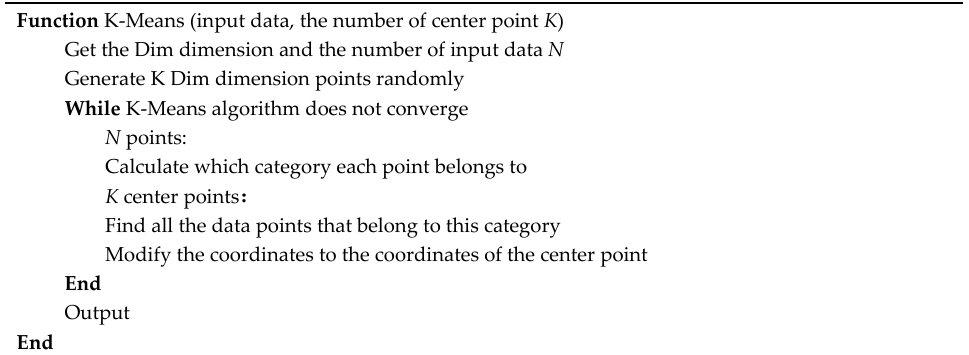
Table 1. The process of K-Means algorithm.